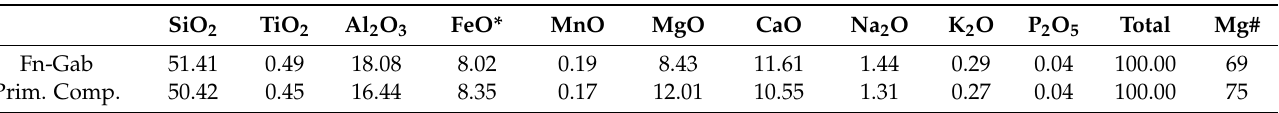
Table 4. Inferred primitive compositions of basaltic magma deduced from the chemical compositions of Fn-gabbro using maximum olivine fractionation method